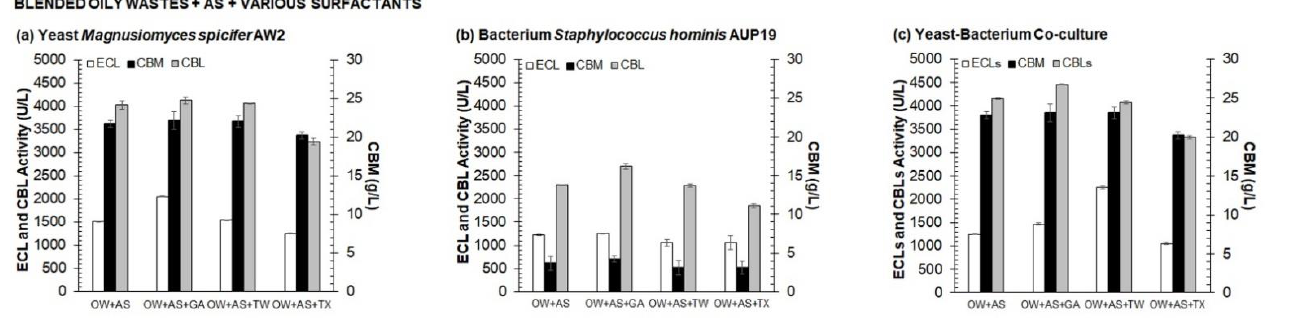
Figure 3. Selection of medium composition by one variable at a time (OVAT) for CBLs production in POME50 + 2.0% ( v / v ) WFO + 0.5% ( w / v ) AS + 0.1% ( v / v ) surfactants, including Gum Arabic (GA), Tween 80 (TW), and Triton X-100 (TX) by pure M. spicifer AW2 ( a ), pure S. hominis AUP19 ( b ), and co-culture M. spicifer AW2 + S. hominis AUP19 ( c ) at room temperature (30 ± 2 °C) with shaking at 150 rpm for 24 h.